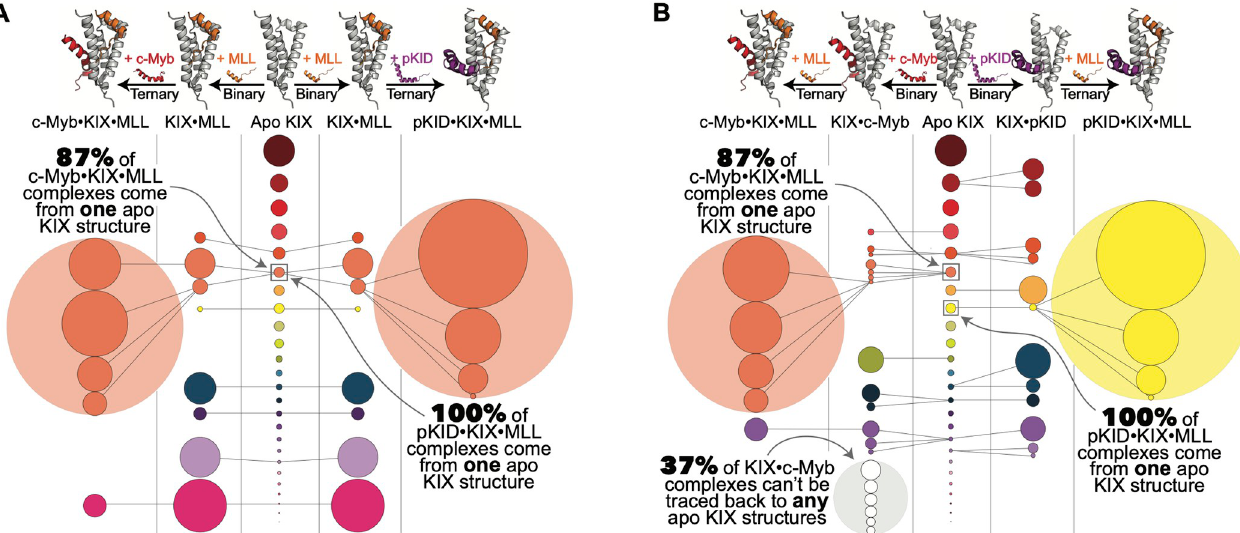
Fig 3. Pathways of KIX conformational selection for native ternary complex formation through binary intermediate complexes. Circles represent KIX micro-state basins that come from K-means clustering analysis (see methods and S1 Text). The diameter of each circle is proportional to the relative population. Circle colors correspond to the cluster origin from the apo KIX distribution (shown in the center). (A) Diminishing states pathways in conformational selection for the (left) c-Myb ternary complex and (right) the pKID ternary complex when MLL binds first versus (B) when c-Myb / pKID bind to KIX